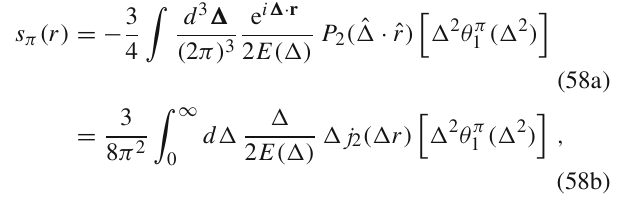
results are drawn in Fig. 4 – lower panel. Focusing on the more realistic curve, obtained using Eq. (57), these forces peak in the neighbourhood upon which the normal pressure switches sign, i.e. where the forces driving the quark and antiquark away from the core are overwhelmed by attractive confinement